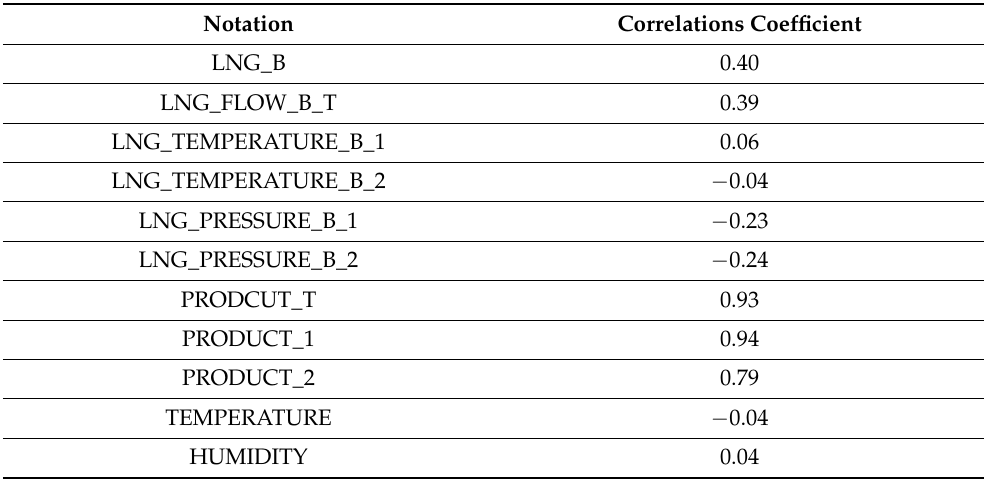
Table 7. Correlations with the LNG consumption of the